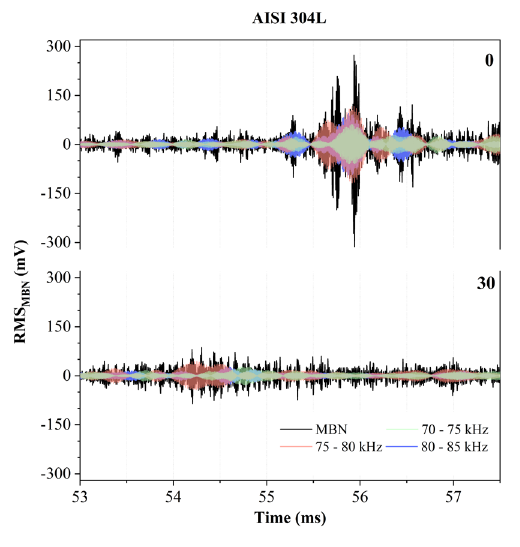
for 304L steel. MBN